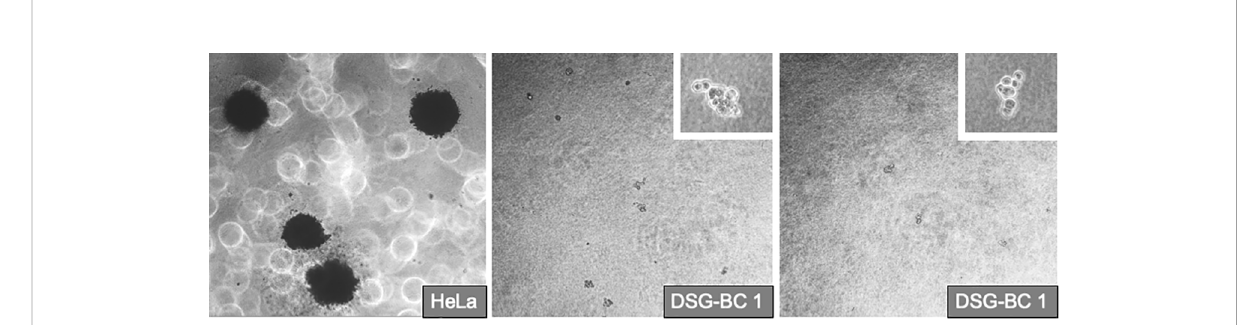
FIGURE 6 Breast cancer cells derived from patients with obesity or normal weight are not able to promote deformation of 3D colonies in soft agar. Even after 2 1/2 weeks after plating in the DSG-BC1 or DSG-BC2 in soft agar no 3D colonies could be detected only isolated cell aggregates could be